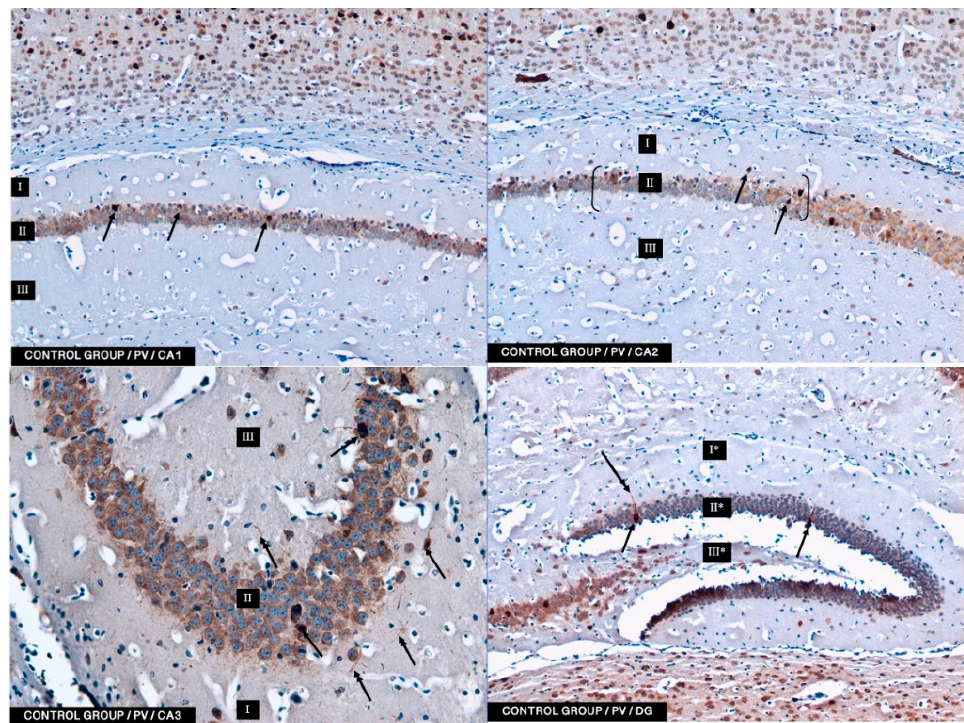
Figure 3. Control group. The immunoreactivity of the PV-IR of moderate neurons of CA1-CA3 mouse hippocampal fields and DG of the hippocampus is observed. ( I : the marginal layer, II : the pyramidal layer, III : the multiform layer; the arrows indicate PV-IR neurons ( single arrow ) and PV-IR fibers ( double arrow ) of the hippocampus; magnification ×20).